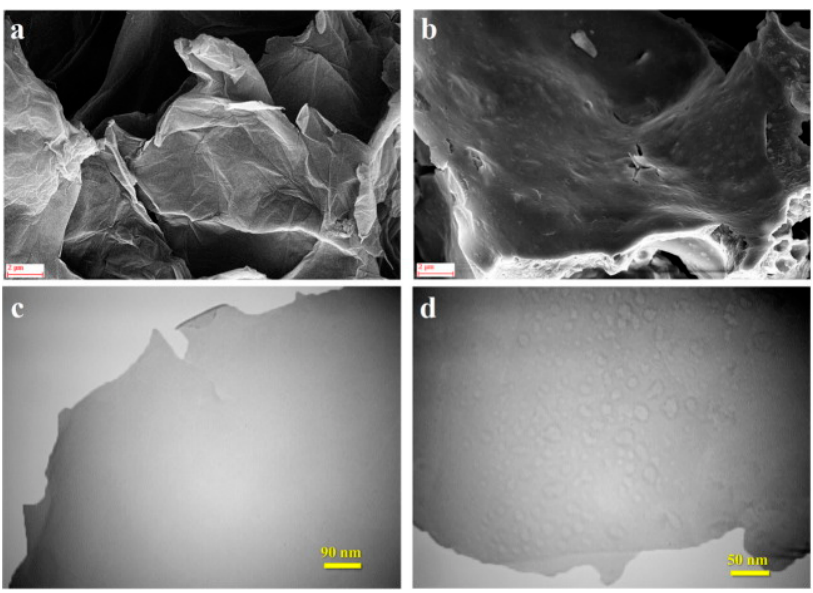
Figure 9. ( a ) FE-SEM image of rGO, ( b ) FE-SEM image of rGO-IIP, ( c ) TEM image of rGO and ( d ) TEM image of rGO-IIP. Reprinted with permission from Ref. [109]. Copyright 2016,